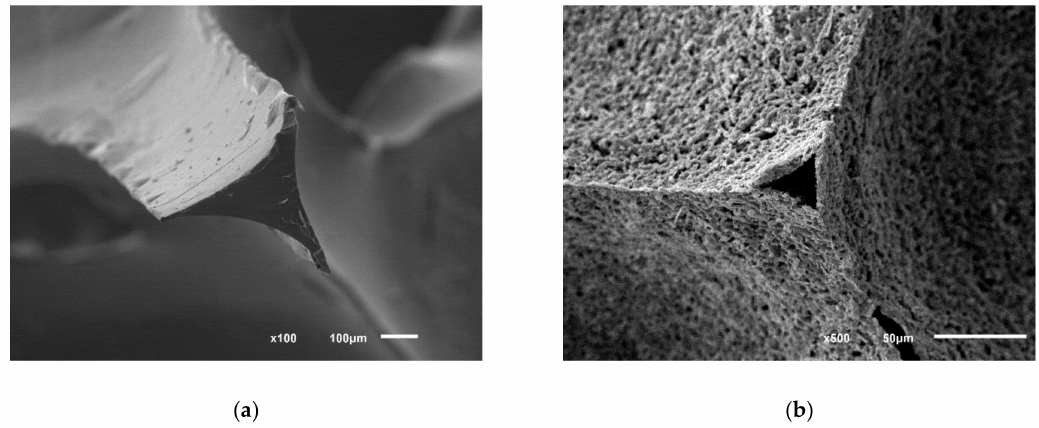
Figure 3. SEM images of a fractured strut wall of ( a ) the sacrificial polymer template and ( b ) the reticulated porous diatomite–kaolin